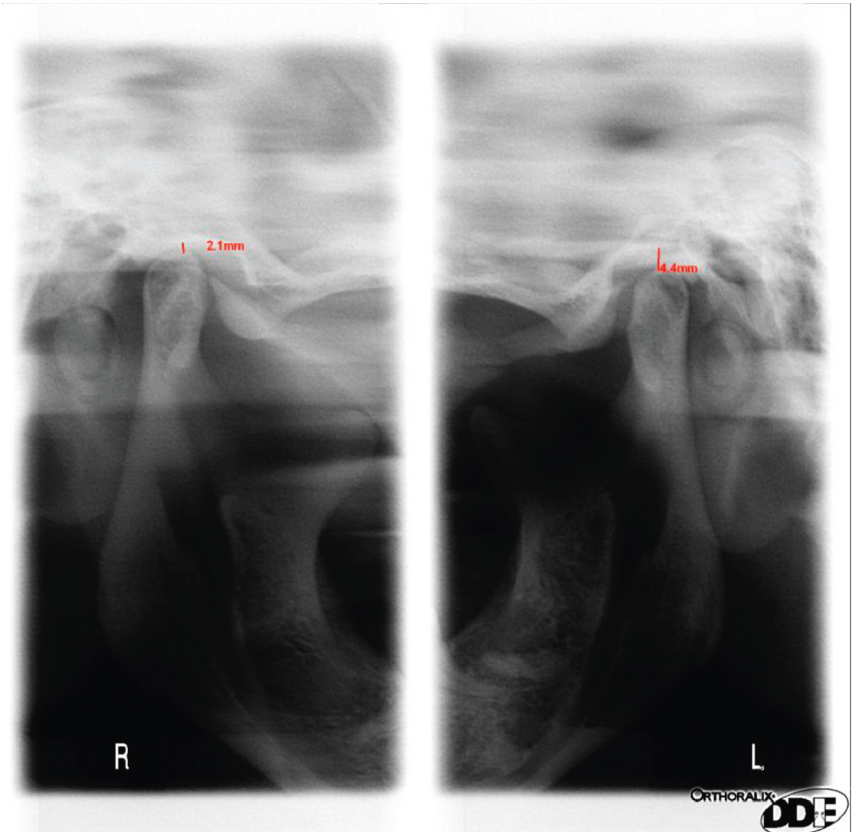
Figure 18: The radiographs of the TMJ and nonconcentric condylar position: in occlusion deficient vertical dimension in the right TMJ (no gap between condyle and fossa in the right TMJ, narrowed joint